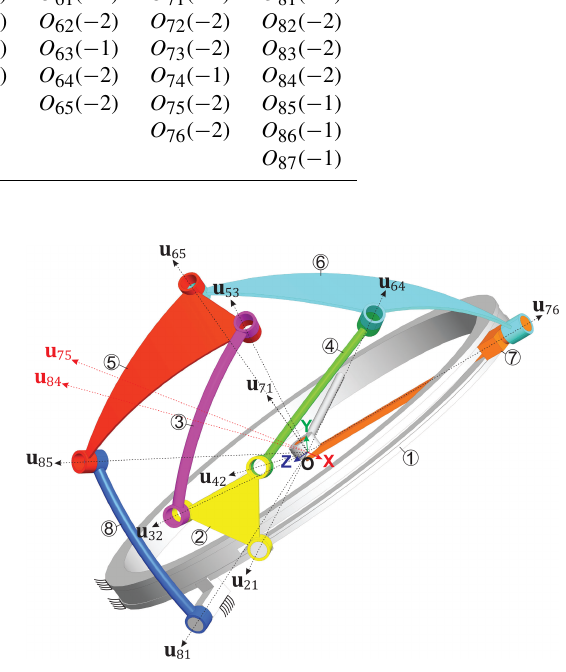
Figure 4. Indeterminate spherical